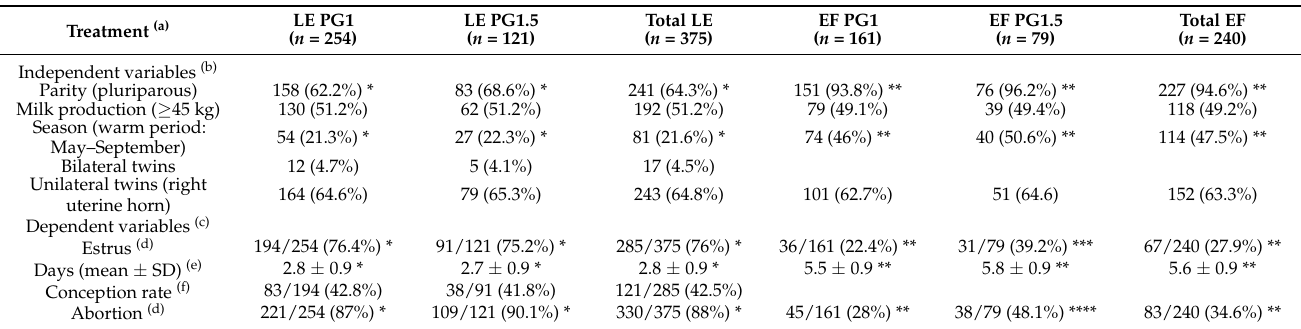
Table 1. Independent variables recorded at the time of treatment and effects of the different treatments on each dependent variable ( n =